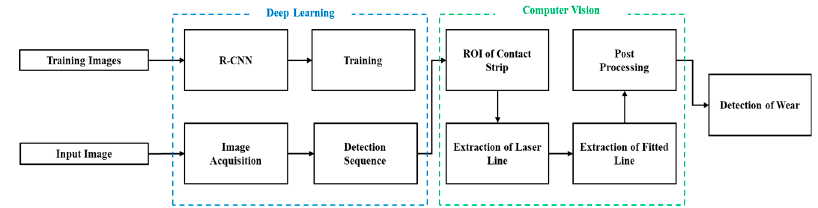
Figure 7. Flow c hart of the wear measurement algorithm for the contact strip. Figure 7. Flow chart of the wear measurement algorithm for the contact